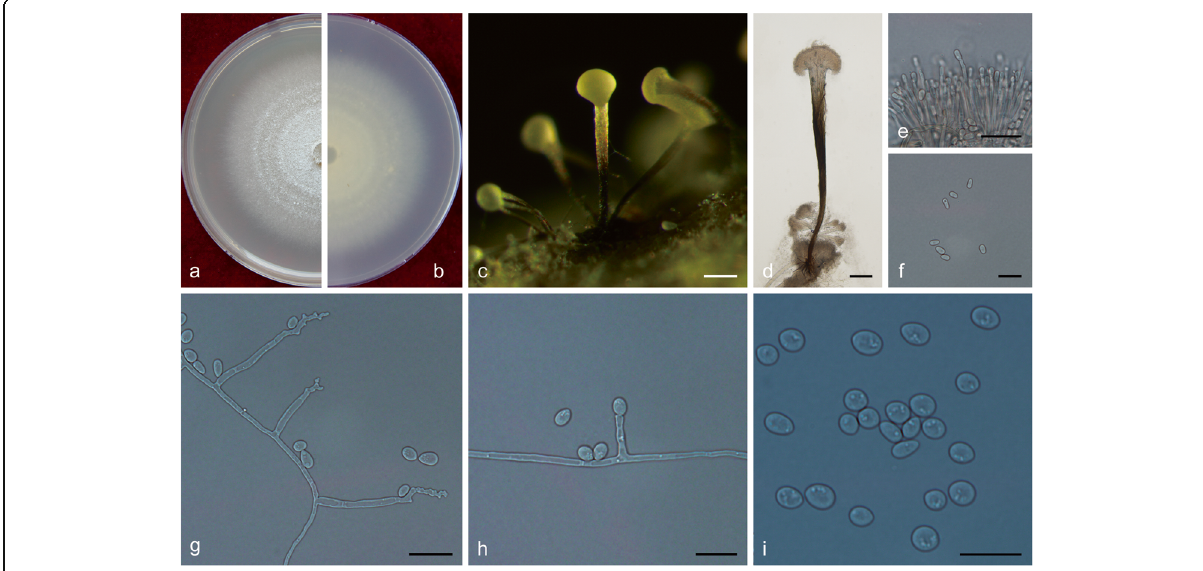
Fig. 19 Morphological characteristics of Ophiostoma xinganense sp. nov. (CFCC 52679, Taxon 11). a – b. Ten-day-old culture on 2% MEA; c – d. Pesotum-like asexual morph; e – f. Conidiogenous cells of pesotum-like asexual morph and conidia; g. Sporothrix-like asexual morph: conidiogenous cells and conidia. h – i. Hyalorhinocladiella-like asexual morph: conidiogenous cells and conidia. Scale bars: c = 100 μ m; d = 50 μ m; e – i = 10 μ